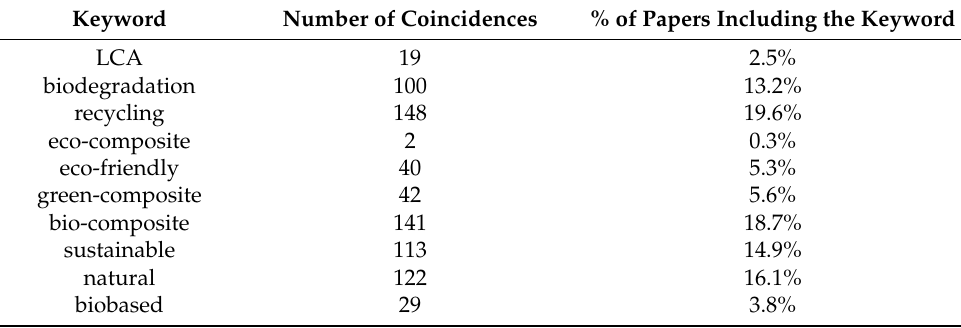
Table 3. Terms and appearance in the bibliographic